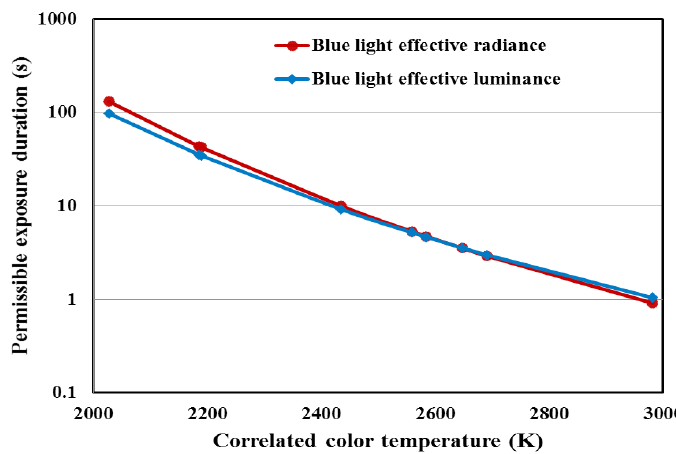
Figure 5. Permissible exposure duration estimated by both blue light effective radiance and blue light effective luminance as a function of CCT of the light source for a source with apparent diameter greater than 0.011 rad